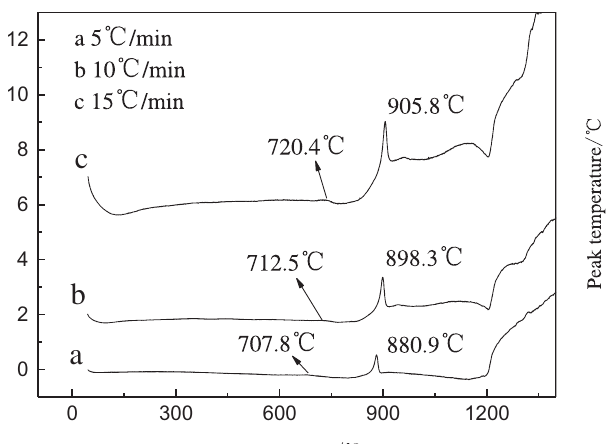
Figure 3: DSC curve of fibers at the acidity coefficient of 1.2.